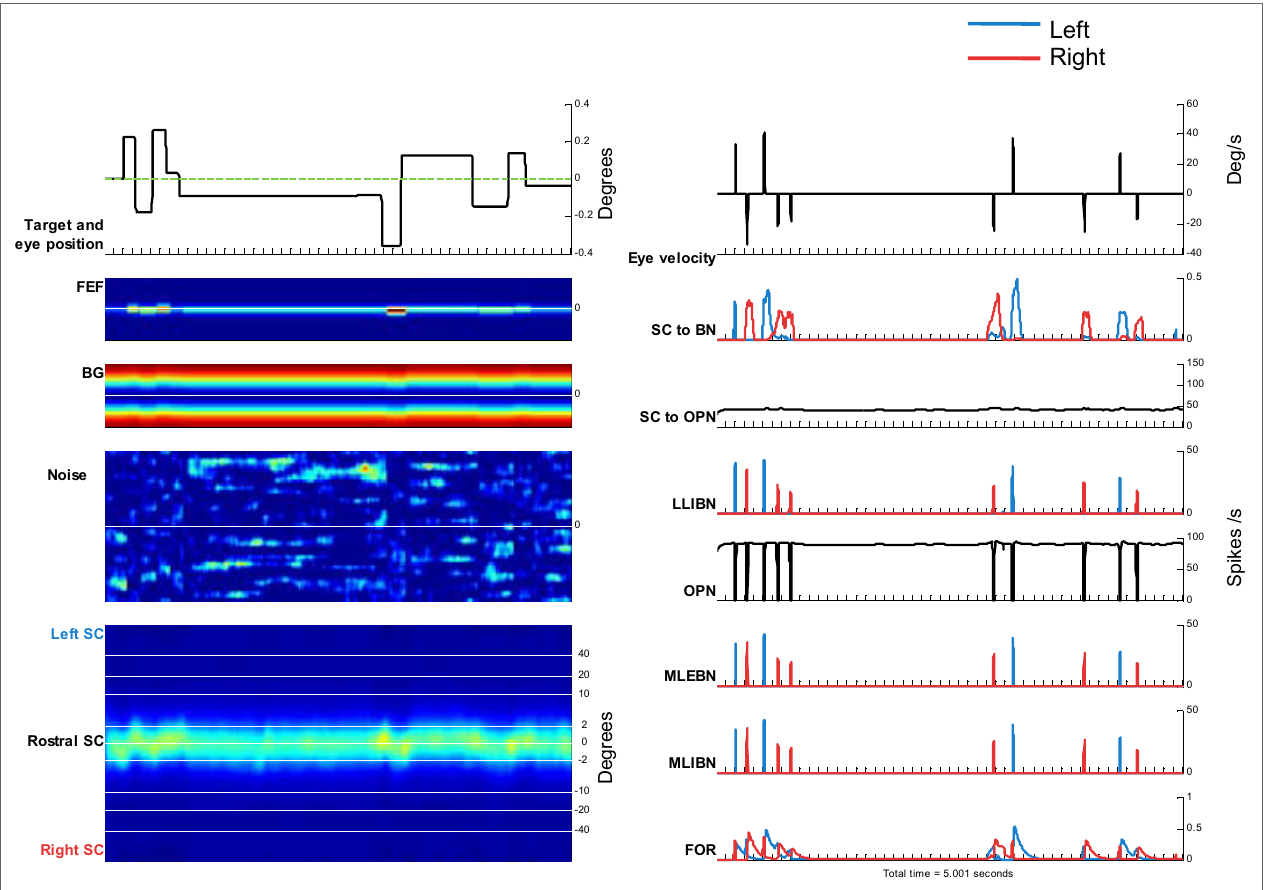
FigUre 6 | Simulation of microsaccades during 5 s of attempted fixation. Left side, from top to bottom: target movement and simulated eye position. Frontal eye field (FEF) activity. Basal ganglia (BG) activity. Superior colliculus (SC) activity. The color plots show the evolution of activity in each map over time, with neurons encoding leftward movements on the top, and neurons encoding rightward movements on the bottom. Right side, from top to bottom: eye velocity. Total projection from SC to burst neurons (BNs) (left BNs in blue and right BNs in red). Total projection from SC to omnipause neuron (OPN). Firing rate of long lead IBN (LLIBN), OPN, medium lead excitatory BN (MLEBN), medium lead IBN (MLIBN), and fastigial oculomotor region